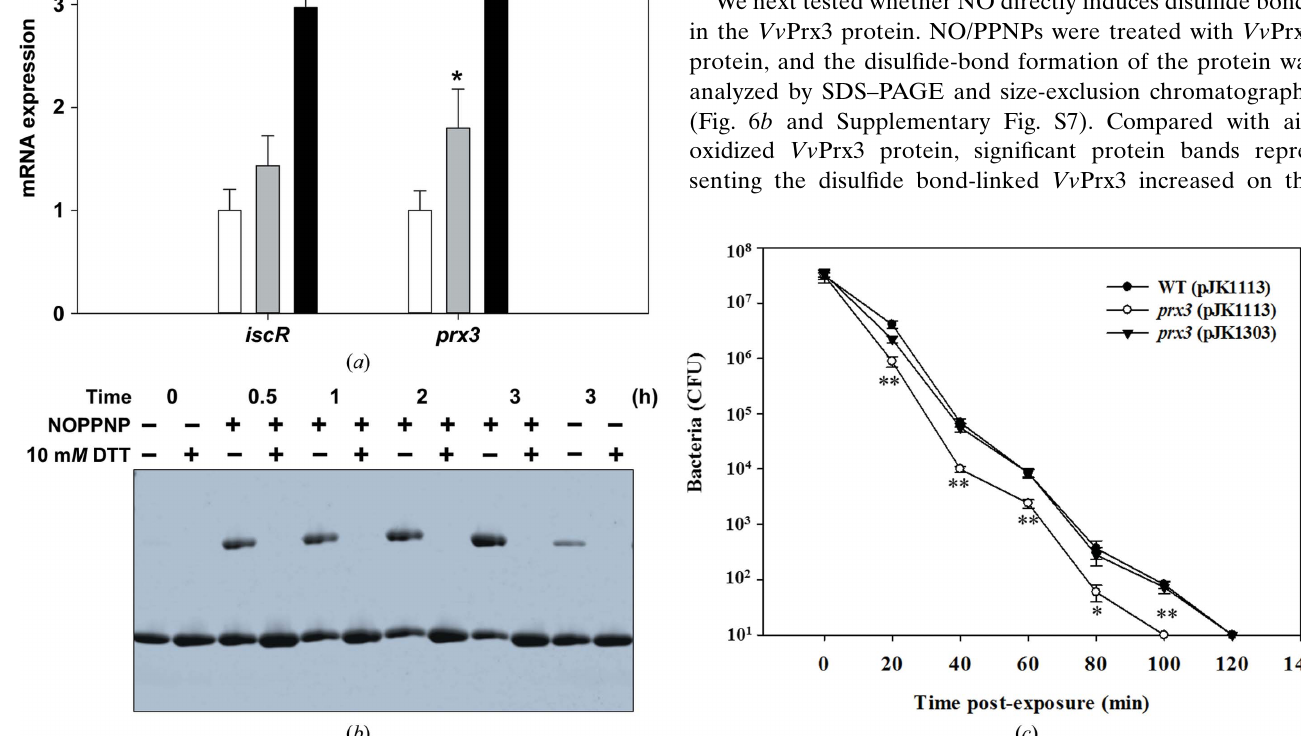
Figure 6 Effect of NO exposure on Vvprx3 expression and Vv Prx3 protein. ( a ) Total RNA was isolated from wild-type cells grown aerobically to an A 600 of 0.5 after exposure to various concentrations of PLGA–PEI nanoparticles (PPNPs) or NO/PPNPs for 20 min. PPNPs were used as blank nanoparticles. The iscR and prx3 mRNA levels were determined by qRT-PCR analyses, and the iscR and prx3 mRNA levels in the wild type exposed to 0.2%( w / v ) PPNPs were set to 1. Error bars represent the standard deviation (SD). *, P < 0.05; **, P < 0.005. ( b ) Vv Prx3 (C73S) was incubated with NO/PPNPs for the times shown. A total of 3.3 m M NO accumulated in the reaction mixture per hour. The reaction was terminated by adding 2.5 m M iodoacetamide to prevent nonspecific disulfide bonds. Aliquots were taken from the reaction mixture and loaded onto SDS–PAGE under reducing conditions (DTT +) or nonreducing conditions (DTT (cid:2) ). ( c ) Survival of V. vulnificus strains in the presence of NO stress. Wild-type bacteria (WT) or prx3 -deleted bacteria ( prx3 ) were transformed with the empty expression vector pJK1113 or the functional prx3 -containing vector pJK1303. Well grown bacterial cells were exposed to NO/PPNPs for the times shown and viable cells were counted as colony-forming units (CFU) on LBS agar plates. Error bars represent the standard deviation (SD). *, P < 0.05; **, P <